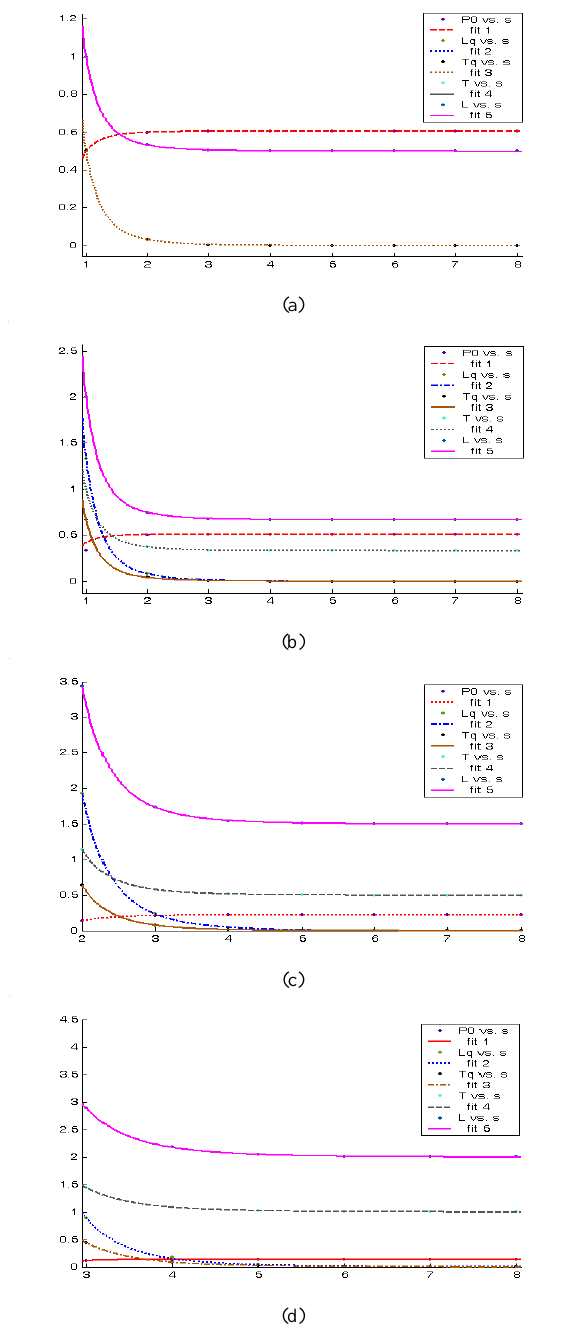
Fig.11. Parameters variety from case 1 to case